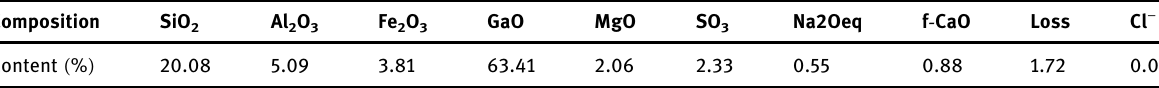
Table 1: Chemical composition of cement Composition